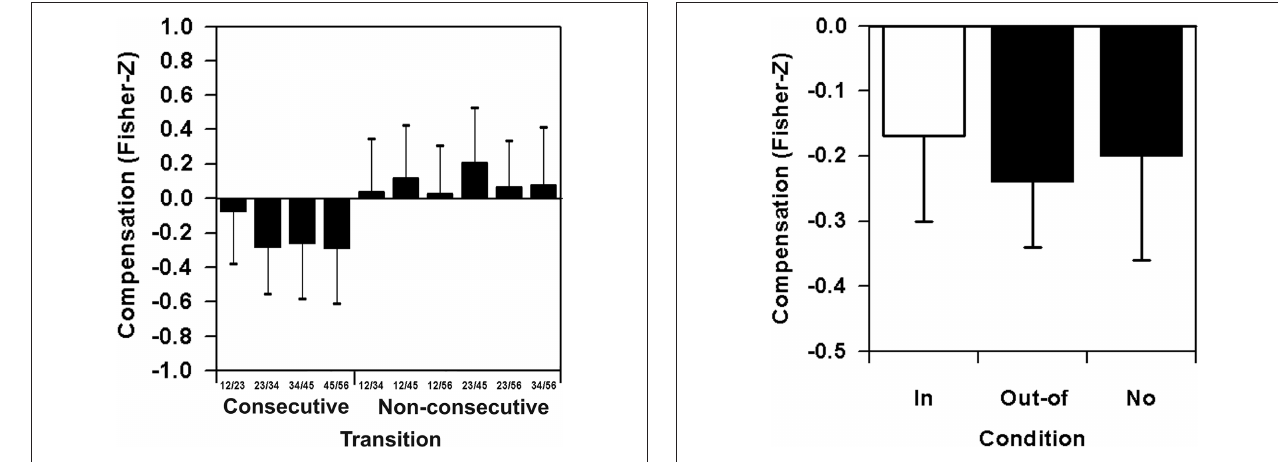
Figure 3 | Lever sequencing: temporal compensation between consecutive time intervals between target configurations and missing compensation effects for combinations of non-consecutive time intervals.